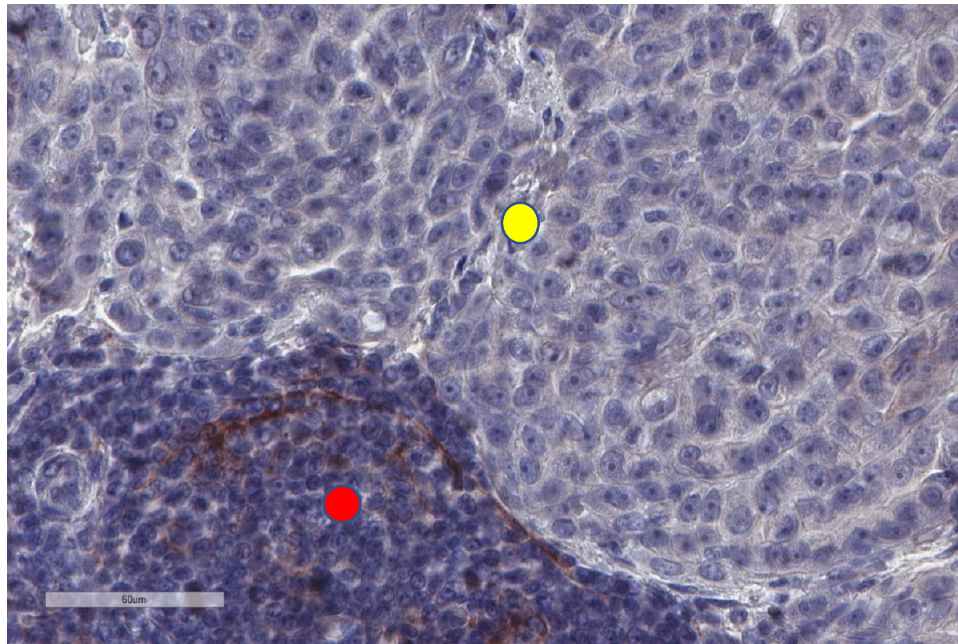
Figure 8. PD-L1 is not expressed by tumour cells (upper part of the image, yellow circle) in this malignant mesothelioma, but there are a few PD-L1+ immune cells in the neighbouring stroma (lower part, red circle). Table 4. Studies with immune checkpoints expression in MPM.